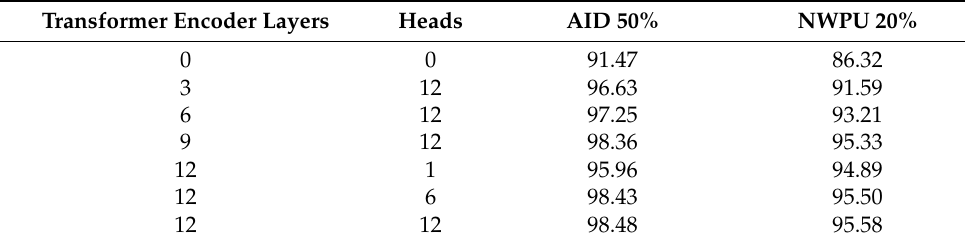
Table 11. Ablation study on transformer